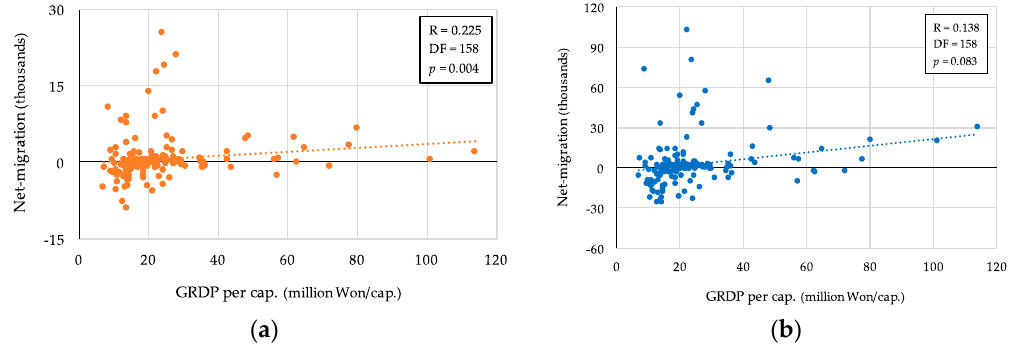
Figure A2. Grose Regional Domestic Product (GRDP) per capita in 2010 and observed net migration: ( a ) in 2011; and ( b ) during 2011–2015.